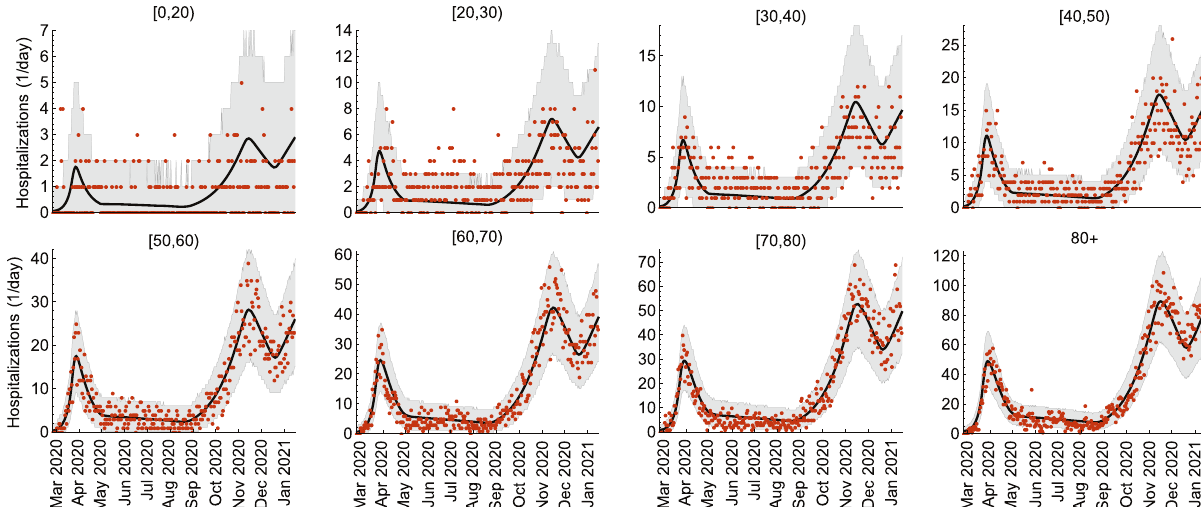
Fig. 1 Model fi t to COVID-19 hospitalizations. The age-strati fi ed daily hospital admission data are shown as red dots. The median trajectories estimated from the model are shown as the black lines. The gray shaded regions correspond to 95% Bayesian prediction intervals based on 2000 parameter samples from the posterior distribution. Hospital admissions were estimated for 10 age groups (see Methods). For presentation purposes, we grouped hospitalizations for ages [0,5), [5,10), [10,20) into the group of [0,20), so only 8 age groups are shown in this fi gure.